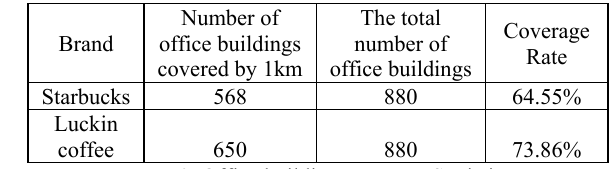
Table 3 . Office building coverage